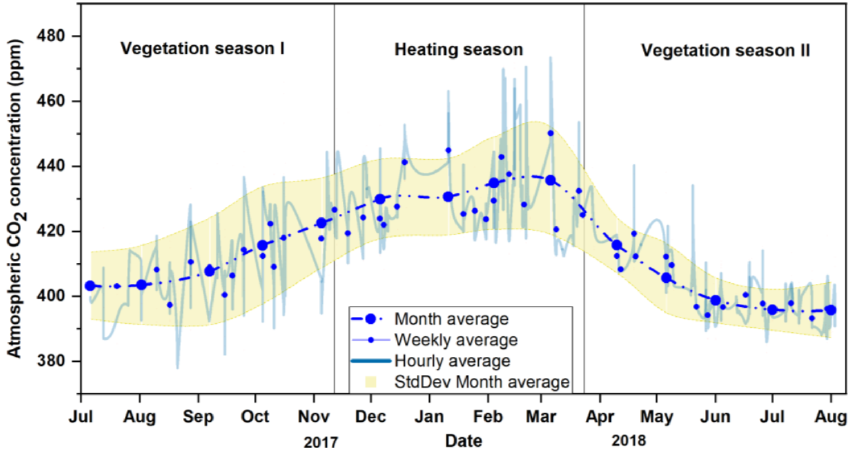
Figure 3. Seasonal patterns of the measured mean atmospheric CO 2 concentration in the sampling sites over the study period (vegetation I, heating, vegetation II, respectively) in July 2017–August 2018. A city-wide average for CO 2 was computed by averaging daily values across all sites. Error areas indicate the standard deviation (2 σ ) of the means.